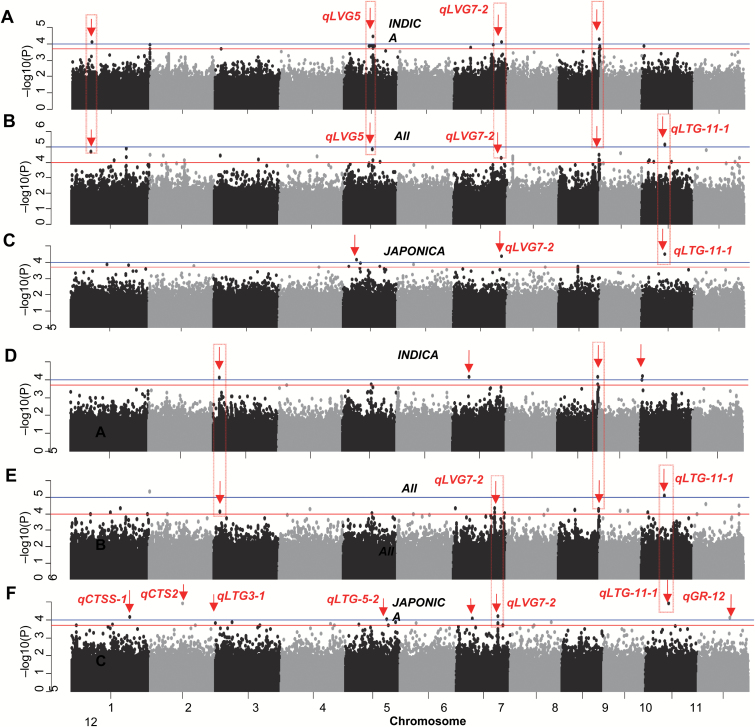
GWAS for LTG in the ALL, JAPONICA, and INDICA groups of accessions. Manhattan plots of LTGI analyzed in INDICA (A), ALL (B), and JAPONICA (C), and of LTGP in INDICA (D), ALL (E), and JAPONICA (F). Red arrows indicate significant SNPs detected in JAPONICA and INDICA. Boxes indicate shared significant SNPs identified by different analyses. For JAPONICA and INDICA, the blue line indicates the significance threshold set at P=1.0 × 10–4, and the red line indicates the minor significance threshold set at P=2 × 10–4. For ALL, the blue line indicates the significance threshold set at P=1.0 × 10–5, and the red line indicates the minor significance threshold set at P=1 × 10–4. On each plot, the X-axis represents SNP positions across the entire rice genome by chromosomes and the Y-axis is the negative logarithmic P-value of each SNP.